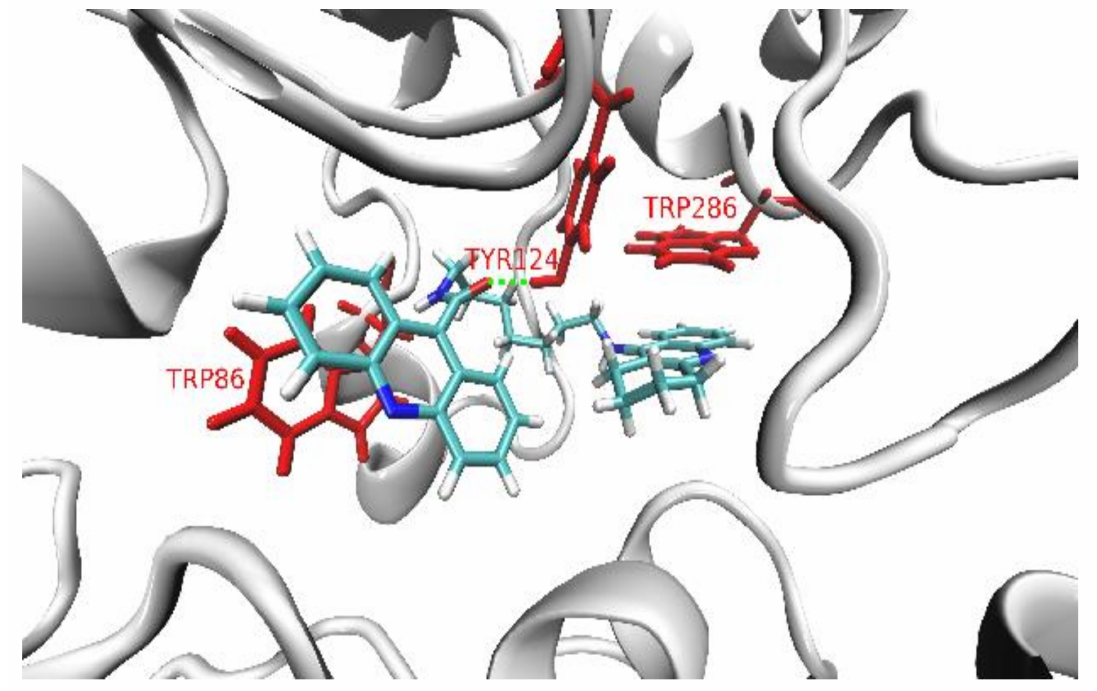
Figure 5. The binding mode of the 3f ligand inside the pocket of AChE. The key ligand-binding aromatic residues in the pocket of AChE are marked in